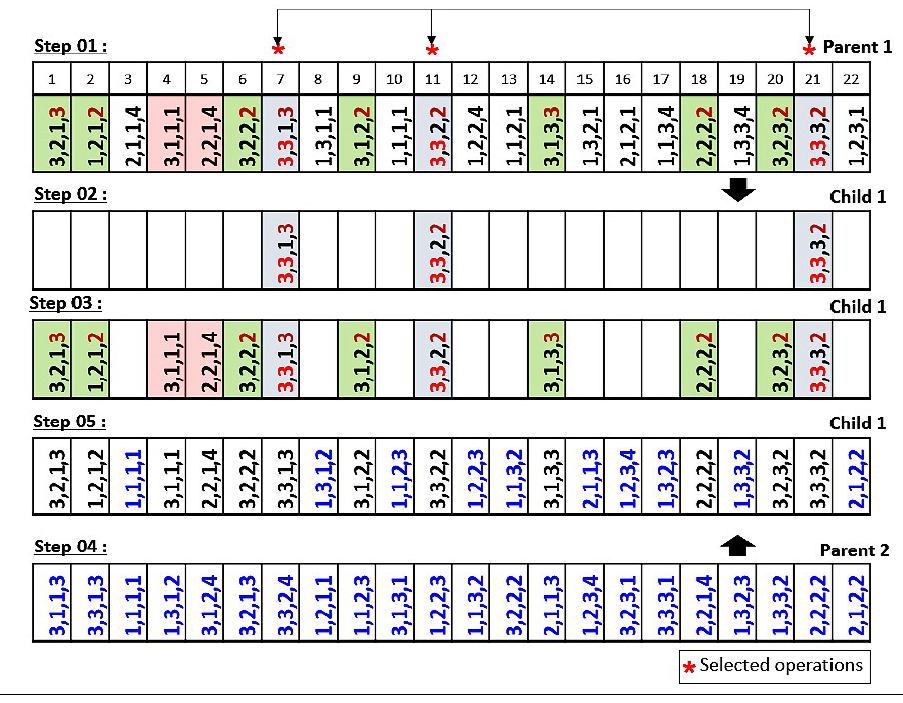
Figure 6. SLOSC2 (sub-lot-level operation sequence crossover 2) operator. It is important to note that, after the application of any crossover operator, in the child chromosome, for a given i and l , the gene ( i , l , j , k ) is located after any gene ( i , l , j (cid:48) , k (cid:48) ) , where j (cid:48) < j . This ensures that precedence constraints between operations of a particular sub-lot are not violated in the new created child